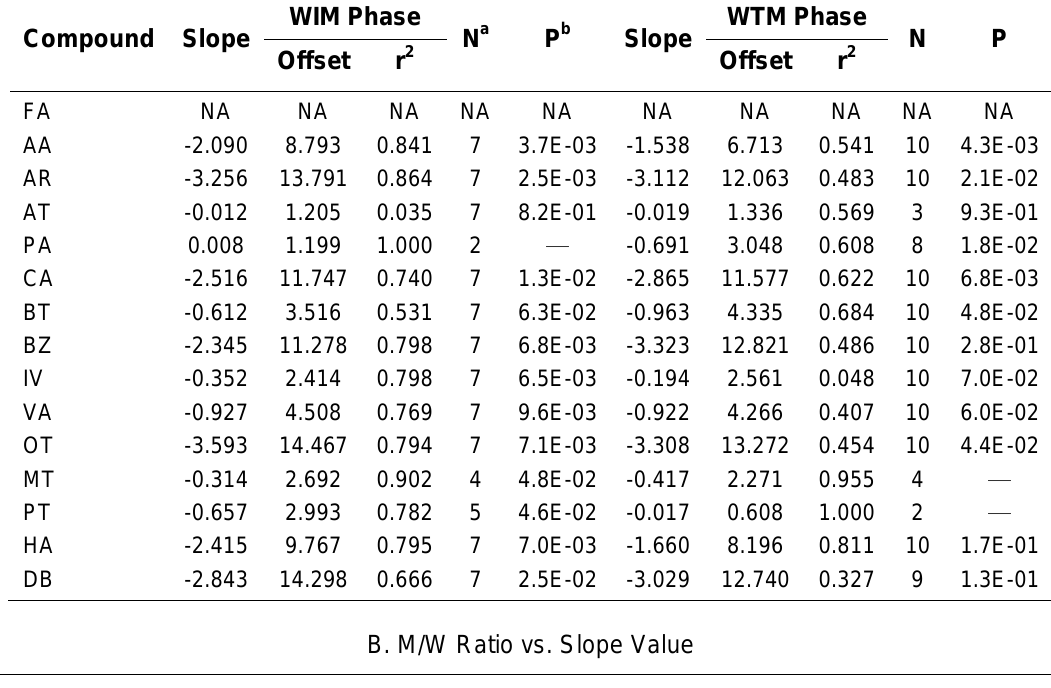
Results of Correlation Analysis between M/W Ratio for All 15 CCs Obtained in Three Types of Data (R Value, Slope Value, and Run Time) s A. M/W Ratio vs. R s